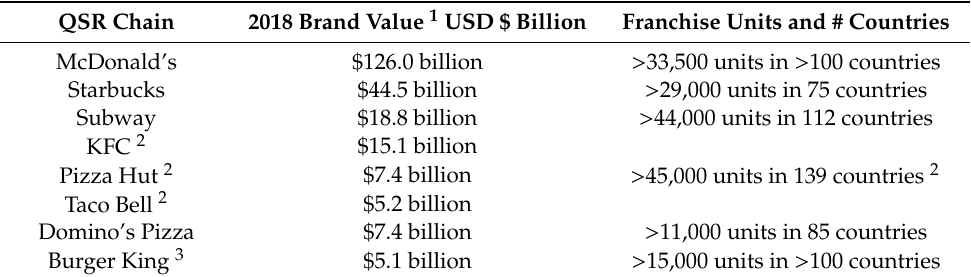
Table 1. Major United States (U.S.)-headquartered transnational quick-service restaurant (QSR) chains, 2018 brand value 1 and number of franchise units in countries where the businesses chains operate worldwide. KFC—Kentucky Fried Chicken; USD—United States